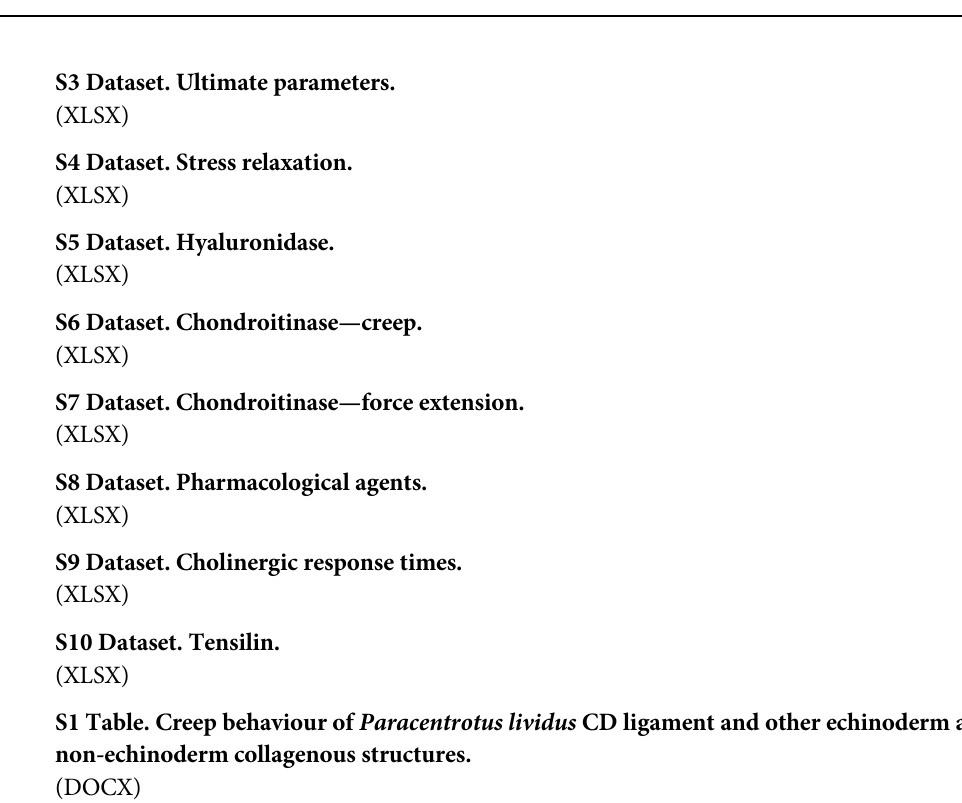
S1 Table. Creep behaviour of Paracentrotus lividus CD ligament and other echinoderm and non-echinoderm collagenous structures. S2 Table. Elastic modulus and ultimate properties of Paracentrotus lividus CD ligament and other echinoderm and non-echinoderm collagenous structures. S3 Table. Stress relaxation of mammalian